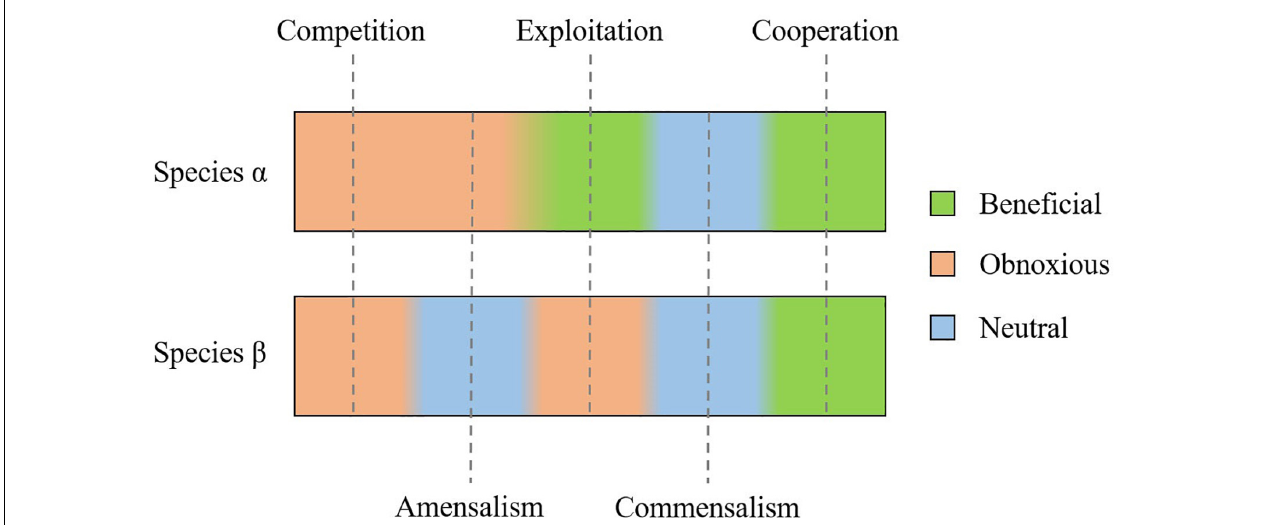
FIGURE 3 | Possible interaction between two bacterial species ( α and β ): competition and cooperation are respectively obnoxious or beneficial for both species. Exploitation is beneficial for species α , at the expense of species β ; whereas amensalism and commensalism do not affect species β , but are respectively obnoxious or beneficial to species α